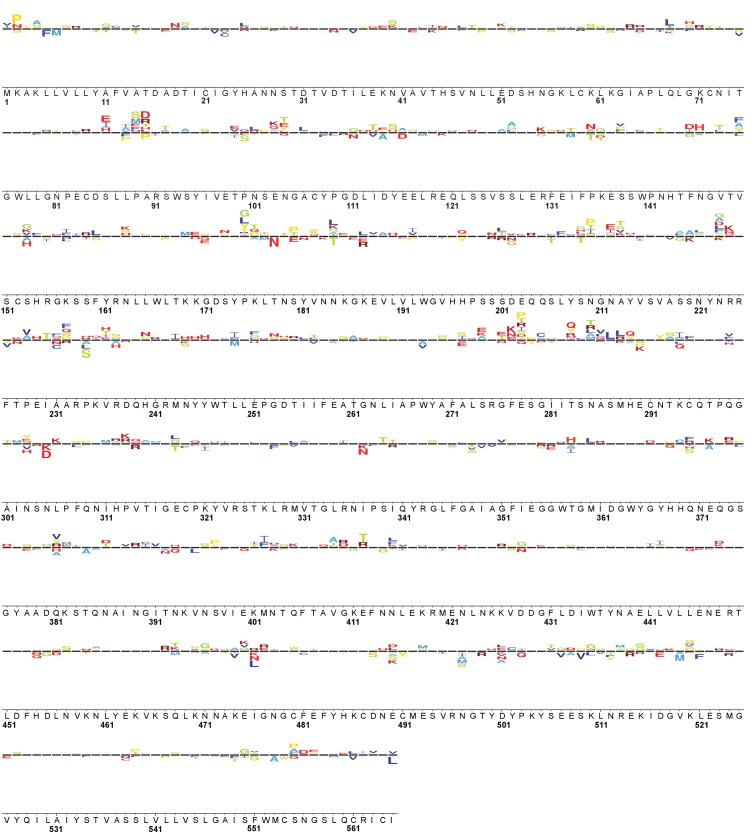
Full WSN HA sequence logo plot: XBP1s 39˚C vs. Basal 39˚C.Logo plot displays variants that behaved consistently across three biological replicates. Variants above the line (representative of selection on wild-type) were enriched upon XBP1s induction at 39˚C; variants below the line were depleted. The wild-type WSN HA residue is shown below the corresponding logo, with the sites numbered below the wild-type sequence (based on sequential numbering of WSN HA). The size of the amino acid letter abbreviation is proportional to the diffsel for that amino acid variant, and all logo plots are plotted on the same scale.